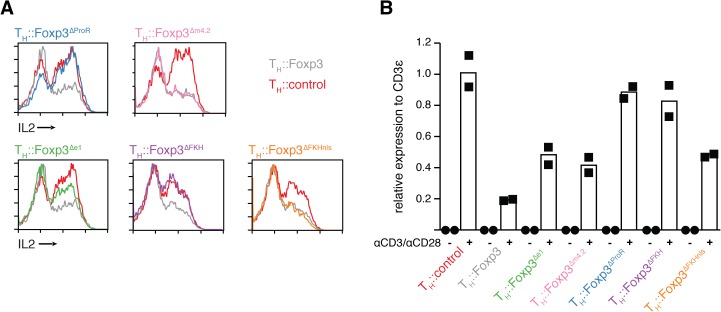
ProR-dependent, FKH-independent regulation of IL-2 upon activation.(A) Activation-induced expression of IL-2 in Foxp3 or Foxp3 mutant transduced cells measured by flow cytometry. Transduced cells were rested and re-activated with cell stimulation cocktail (PMA and ionomycin with protein transport inhibitor) before staining. Data are representative of three independent experiments. (B) Expression of Il2 mRNA in Foxp3 or Foxp3 mutant transduced cells at resting or re-activation state was determined by quantitative RT-PCR relative to the expression of CD3ε. Circles indicate measurements from resting cells, square measurements from reactivated cells. Height of the bars indicates the mean of the two experiments.